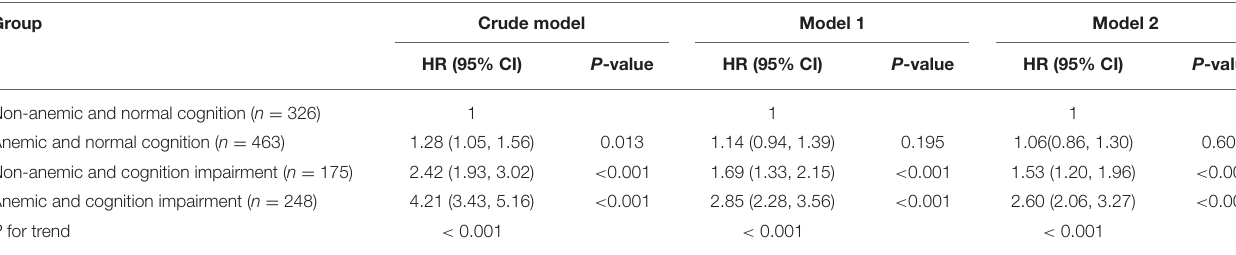
TABLE 3 | Hazard ratios for the combined associations of anemia and cognitive impairment with all-cause mortality. Group Crude model Model 1 Model 2 HR (95% CI) P -value HR (95% CI) P -value HR (95% CI) P